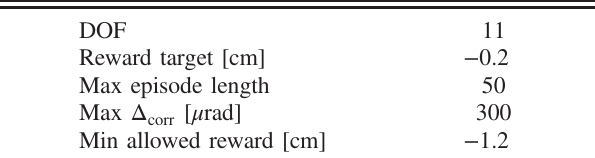
TABLE I. AWAKE horizontal steering NAF agent training parameters.